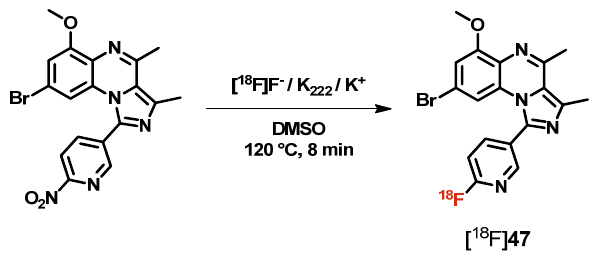
Scheme 13. Scheme 13. Radiosynthesis of [ 18 F] 47 .